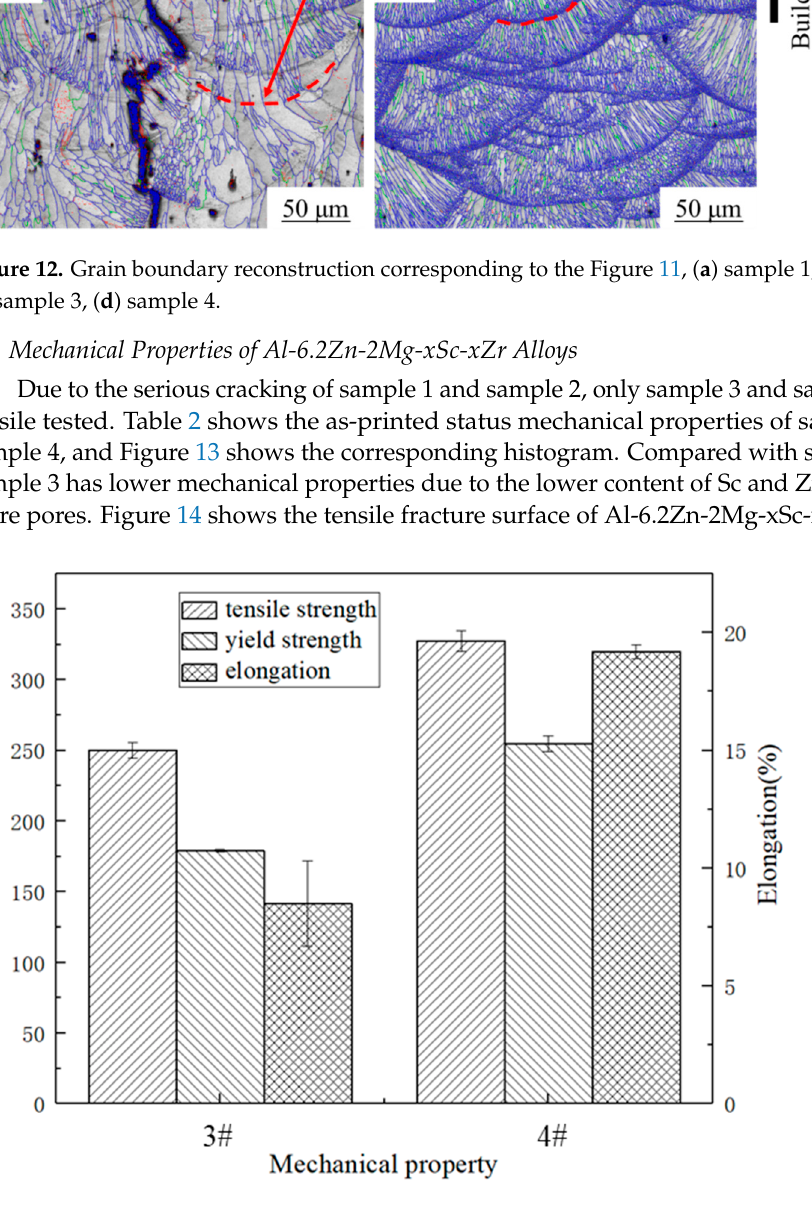
Figure 13. Mechanical properties of the as-printed Al-6.2Zn-2Mg-xSc-xZr alloys.